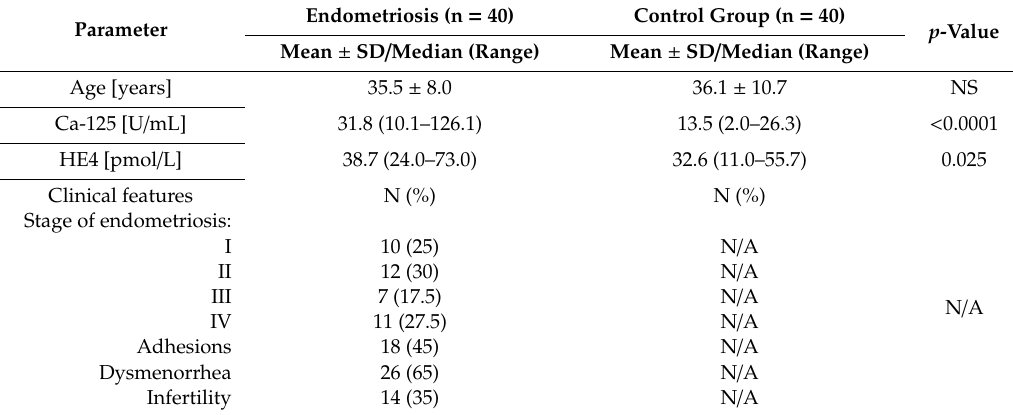
Table 1. Basic characteristics of the study and the control